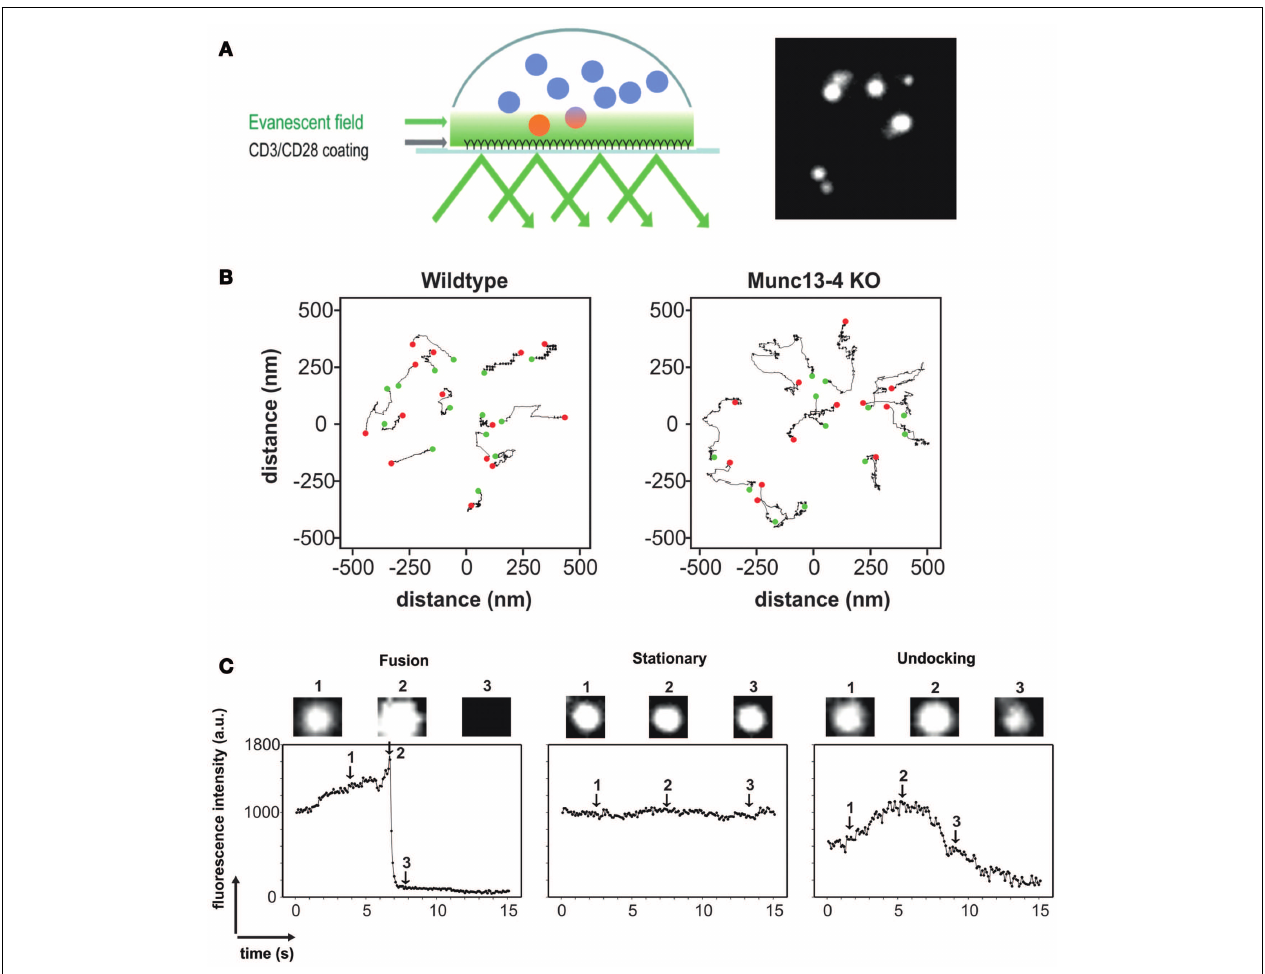
represents the starting position of the LG and the red dot represents the end position of the LG.The absence of the priming factor Munc13-4 leads to a significant increase in vesicle mobility inTIRFM (28). (C) Fluorescence profile of a fusing LG (left), a stationary LG (middle), and an LG that is undocking (right) as seen inTIRFM. Acquisition frequency was 10Hz. Granzyme B-TFP was used to label